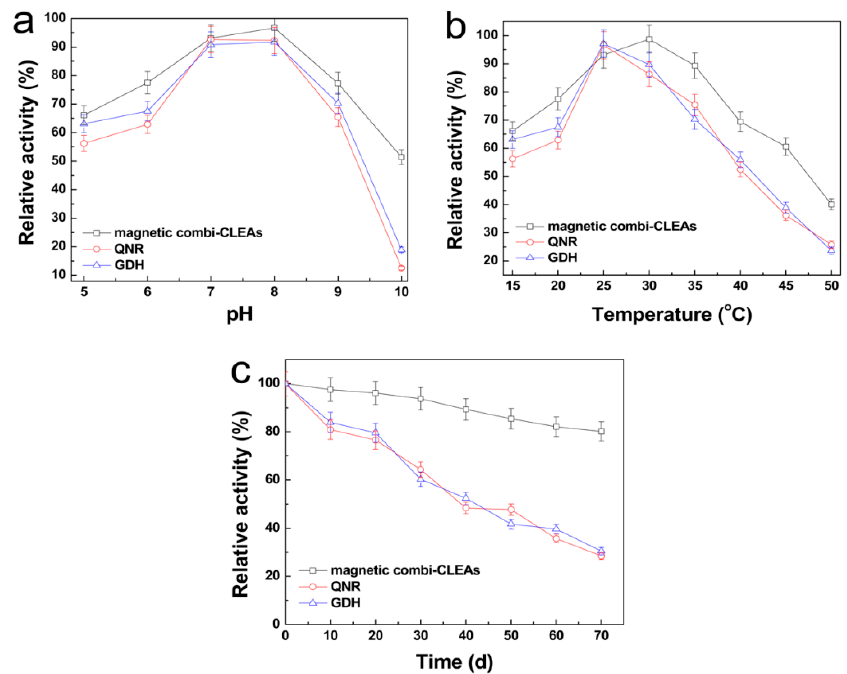
Figure 7. Effect of pH and temperature on the free enzyme and magnetic combi-CLEAs activity. ( a ) pH, ( b ) temperature and ( c ) storage stability of the free enzyme and magnetic combi-CLEAs. Activity was assayed at 25 °C in the standard reaction medium at pH 7.5–8.0. The measurements were performed in triplicate.